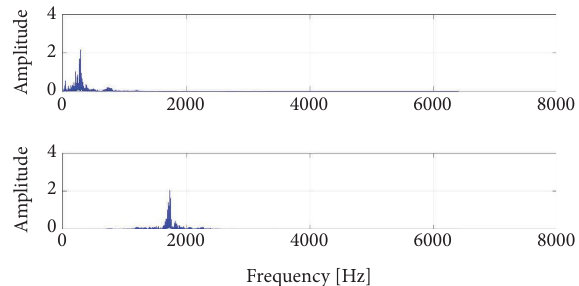
Figure 9: Fourier transforms of two early BLIMF components.